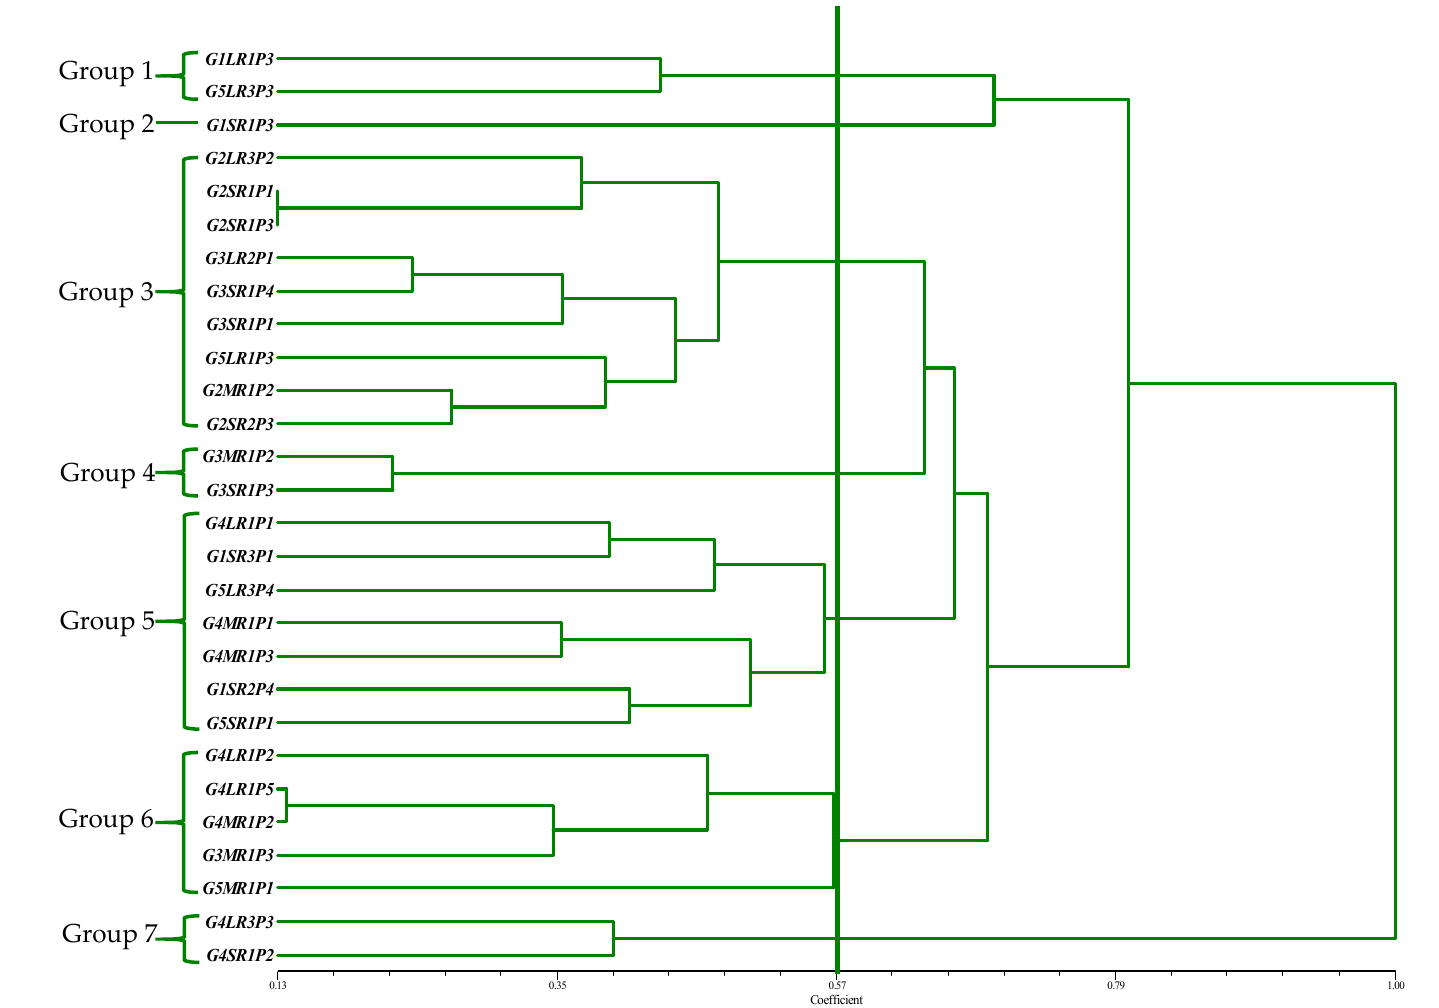
Figure 1. The figure describes the pattern of clustering which divided the 28 Bambara groundnut genotypes into seven groups at a 0.57 dissimilarity coefficient based on their morphological traits. Note : The genotype code abbreviation is in Table 1.